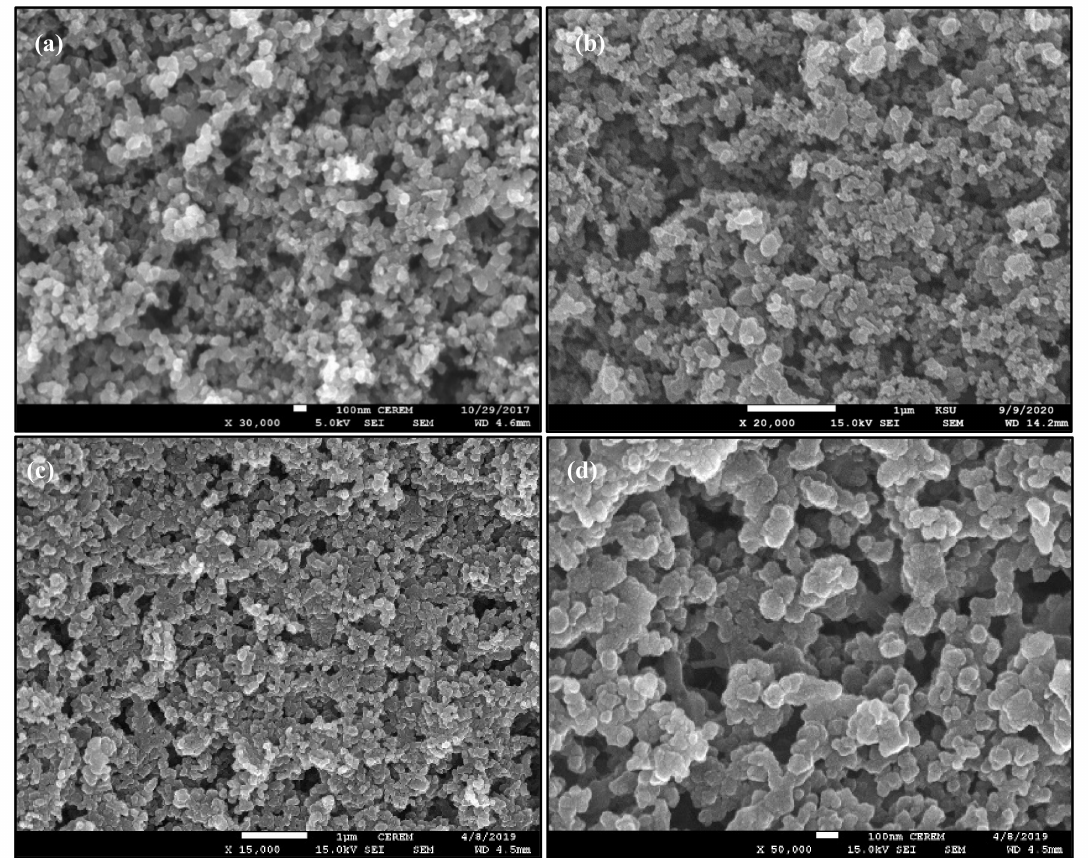
Figure 2. Morphological examination of Ni(OH) 2 /CP based electrodes prepared from two mediums. FE-SEM micrographs of CP ( a ), Ni(OH) 2 -deionized water (DW)/CP catalysts prepared under aqueous medium ( b ), and Ni(OH) 2 - dimethyl sulfoxide (DMSO)/CP electrodes ( c , d ) obtained through an electrodeposition approach through DMSO